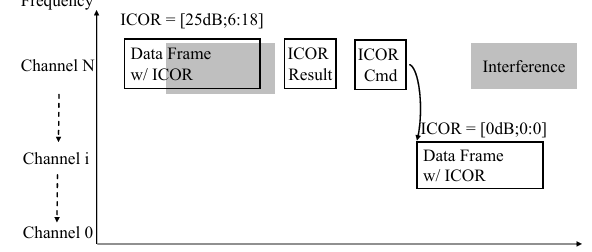
Figure 15. Interference mitigation with interference cognition on